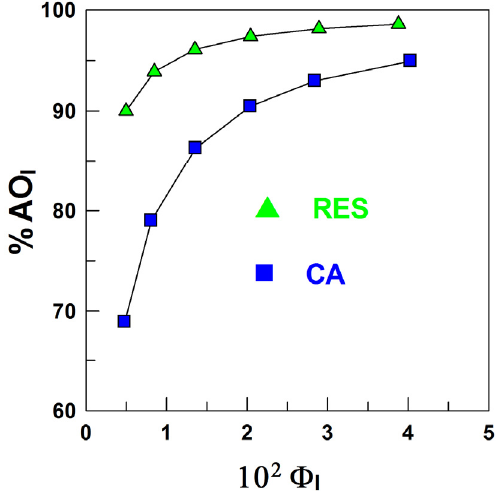
Figure 6. Percentage of resveratrol (-  -) and caffeic acid (-  -) in the interfacial region of corn oil in water emulsion (4:6, O/W). Experimental conditions: [RES] = 1.3 mM, [CA] = 4.4 mM, citrate buffer 0.04 M (pH 2.14 for RES and pH 3.65 for CA). T = 25 °C. Data for CA were taken from